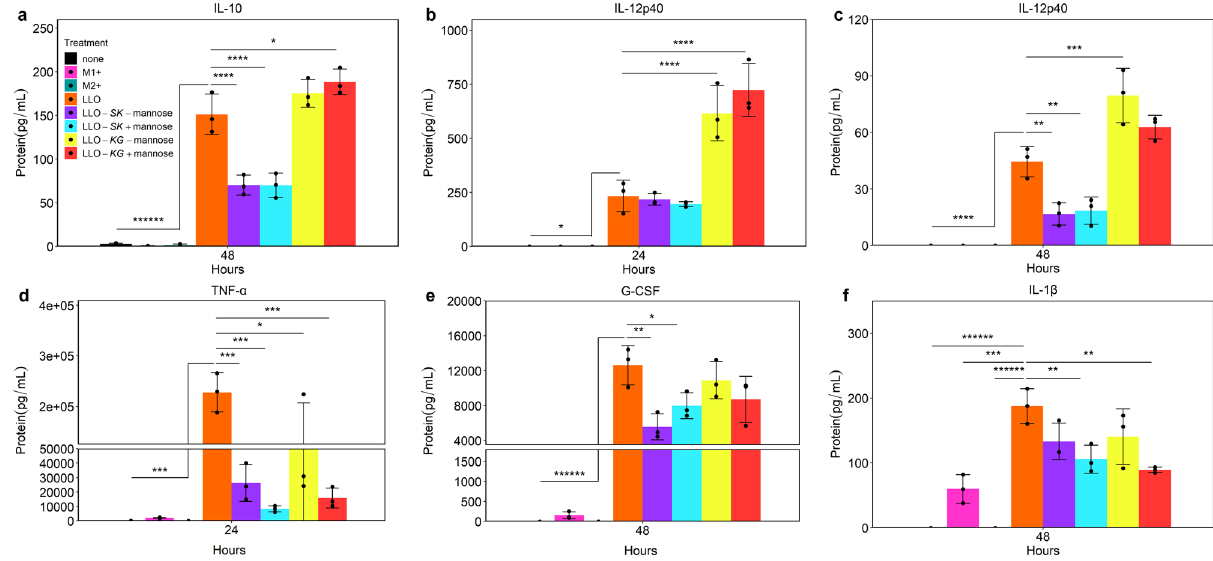
Fig. 6 TF-expressing strains modulated cytokine and chemokine expression in J774A.1 cells. Cytokine and chemokine protein concentrations were assayed by Luminex in untreated J774A.1 cells (none), and in cells treated with LPS and IFN- γ (M1 + ), IL-4 and IL-13 (M2 + ), LLO strain (LLO), LLO- SK with and without mannose (LLO- SK -mannose, LLO- SK + mannose) and LLO- KG with and without mannose (LLO- KG -mannose, LLO- KG + mannose) at 24 and 48 h-post initial treatment; ( a ) IL-10 at 48 h, ( b ) IL-12p40 at 24 h, ( c ) IL-12p40 at 48 h, ( d ) TNF-alpha at 24 h, ( e ) G-CSF at 48 h, and IL-1beta at 48 h. The most prominent protein changes are shown; 14 of the 17 proteins in the panel revealed gene-speci fi c distinctions between the LLO- SK and LLO- KG strains. Plotted data is mean ± SD from n = 3 biological replicates; * p < 0.05, ** p < 0.01, *** p < 0.001, **** p < 0.0001, ****** p < 0.000001. Signi fi cance shown is comparing LLO treatment to all other